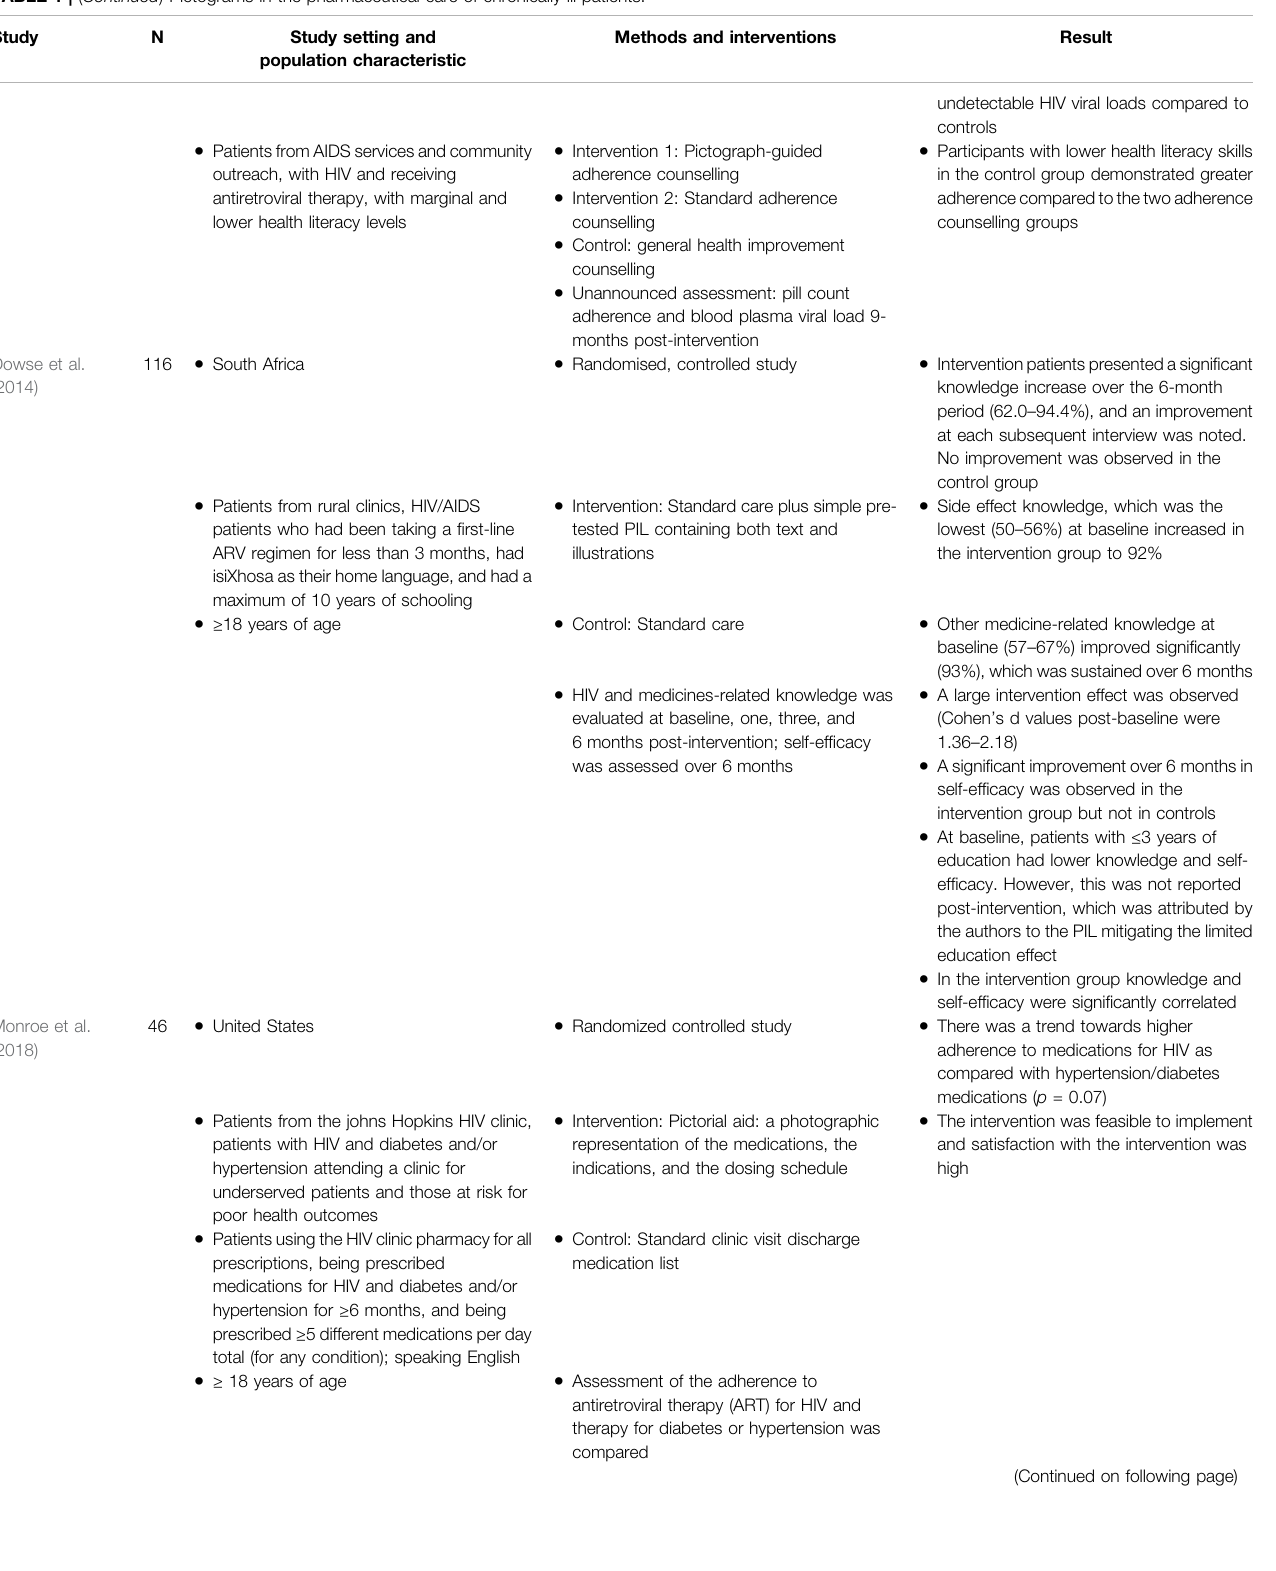
TABLE 1 | ( Continued ) Pictograms in the pharmaceutical care of chronically ill